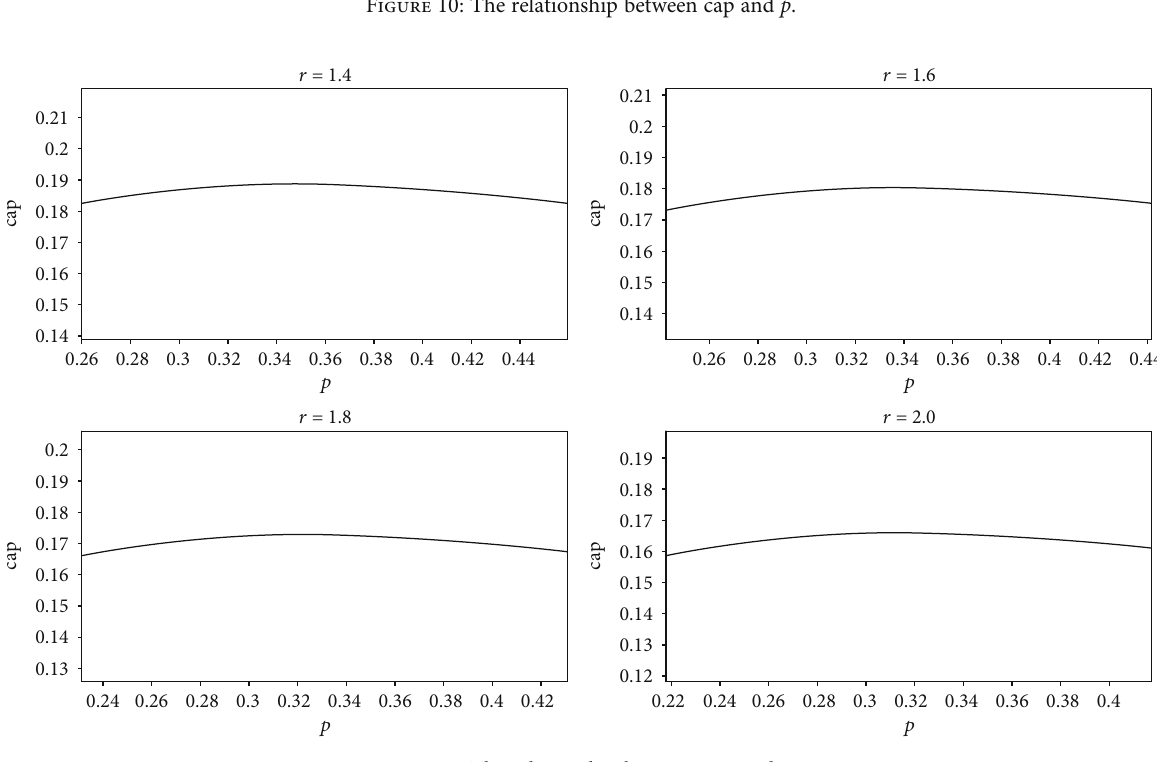
Figure 10: The relationship between cap and p .